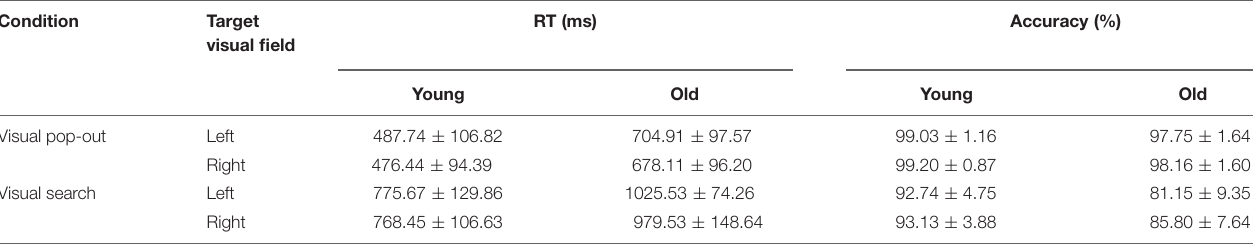
TABLE 1 | Behavioral results (mean ±